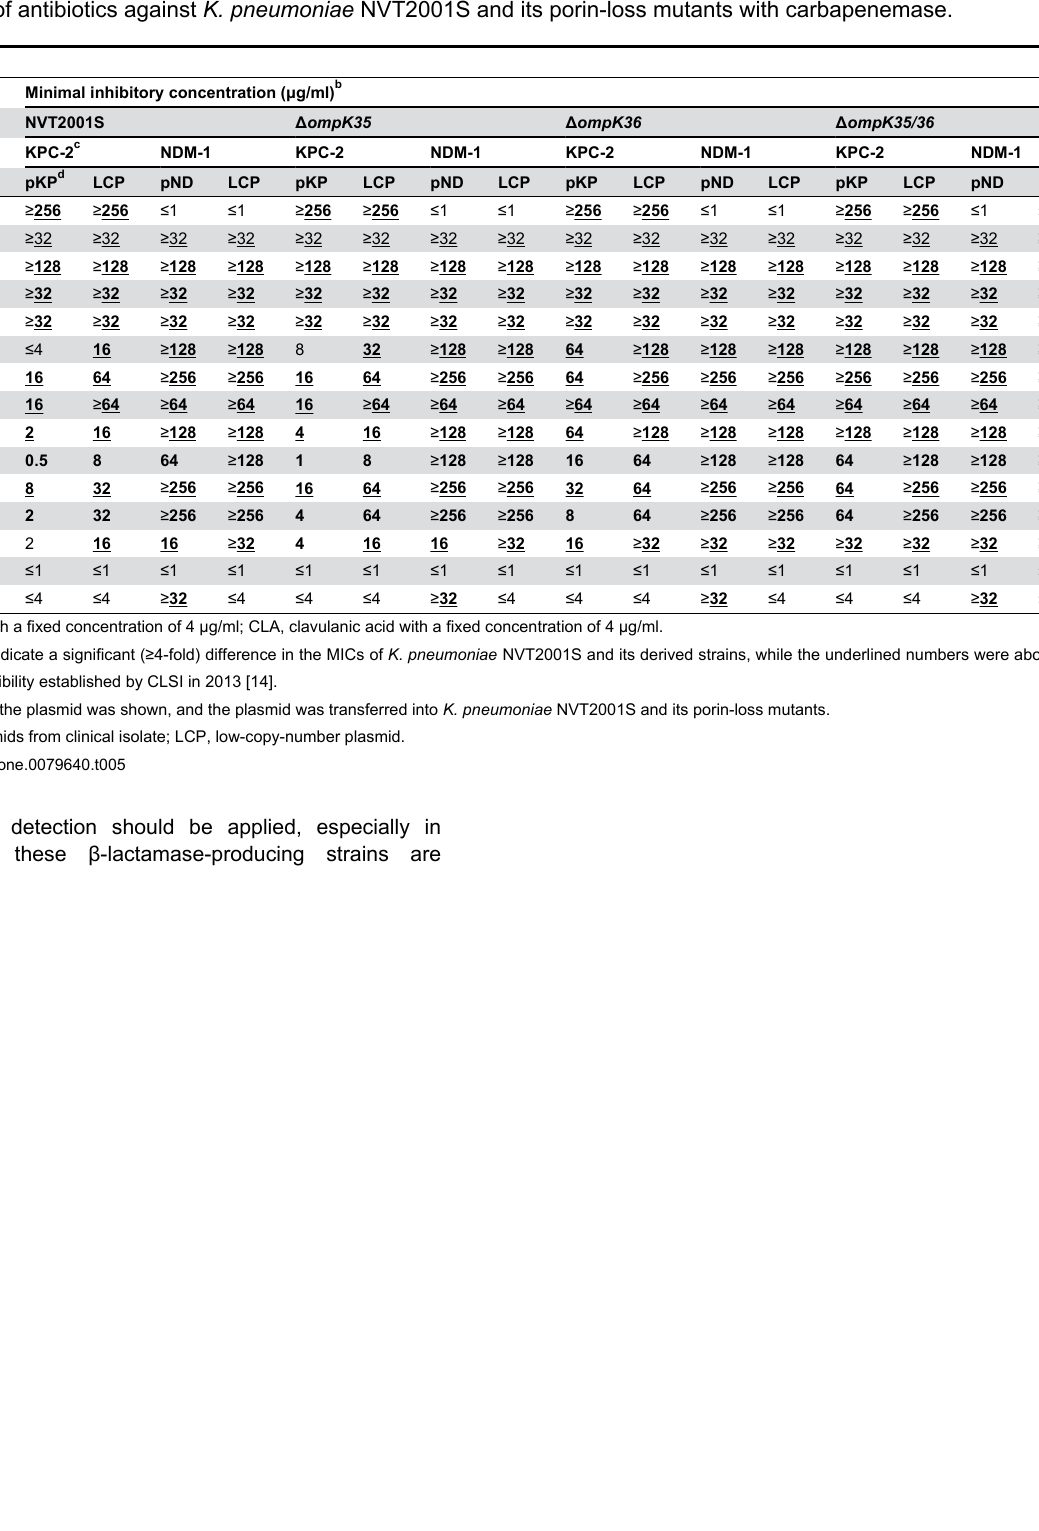
Table 5. MICs of antibiotics against K. pneumoniae NVT2001S and its porin-loss mutants with carbapenemase.